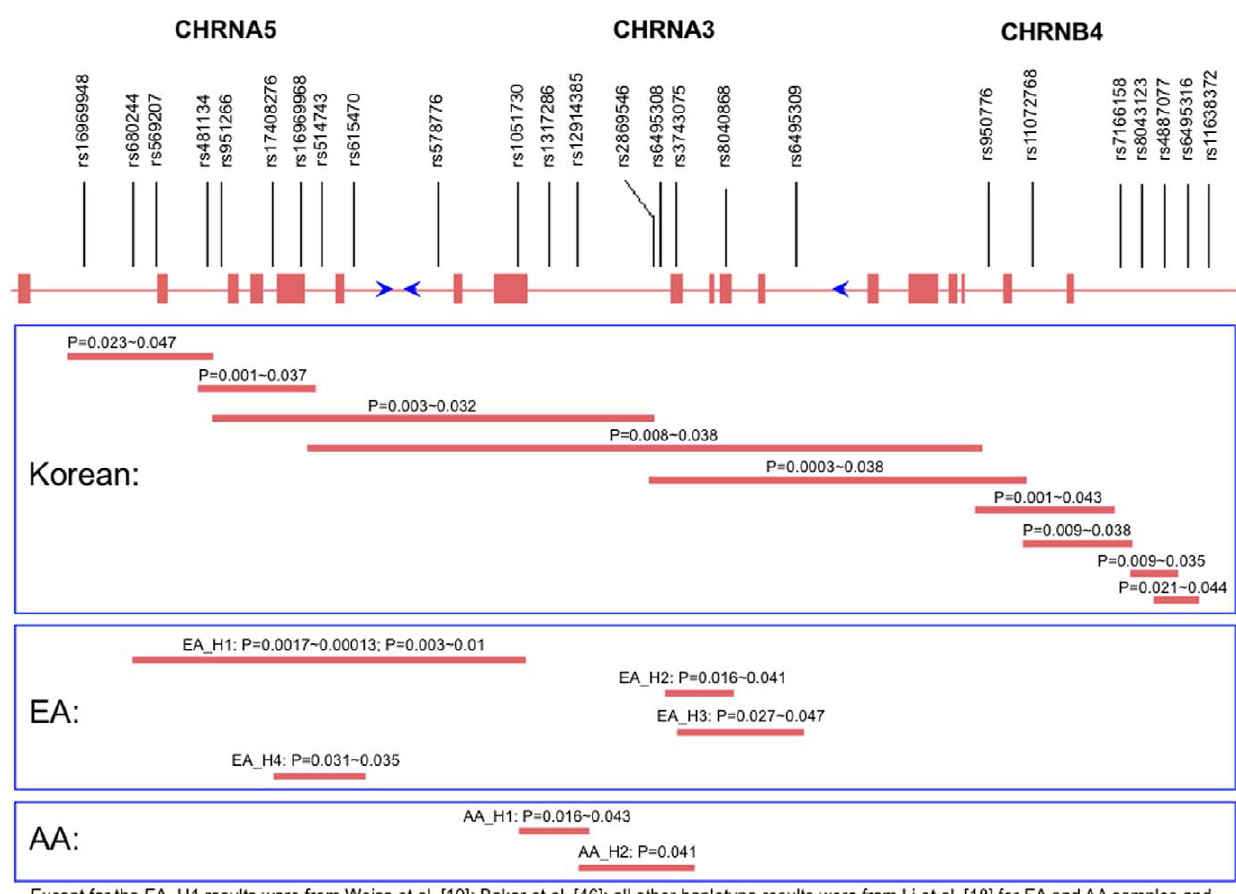
Figure 3. A summary of all reported haplotypes that have been significantly associated with different smoking behaviors in the AA, EA and Korean samples.